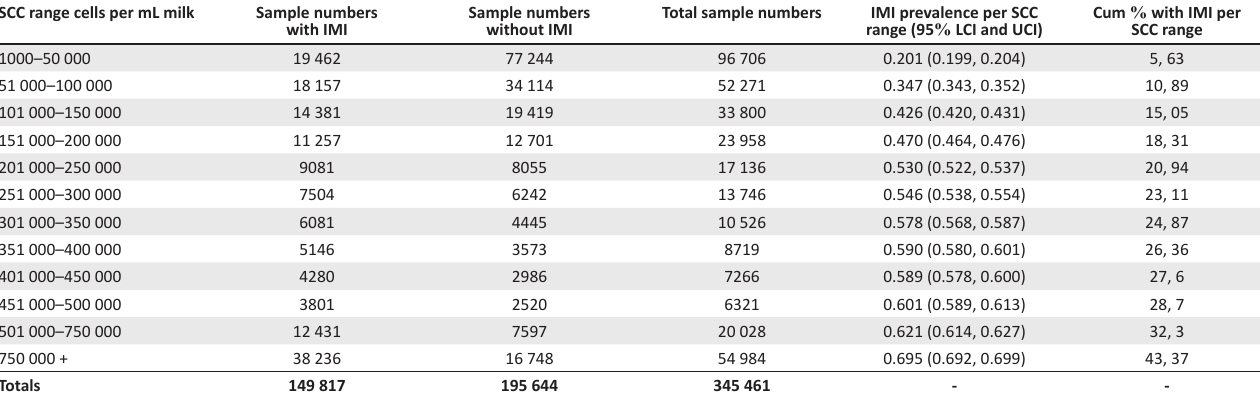
TABLE 1: The presence and absence of intramammary infection within each somatic cell count range in composite milk samples. SCC range cells per mL milk